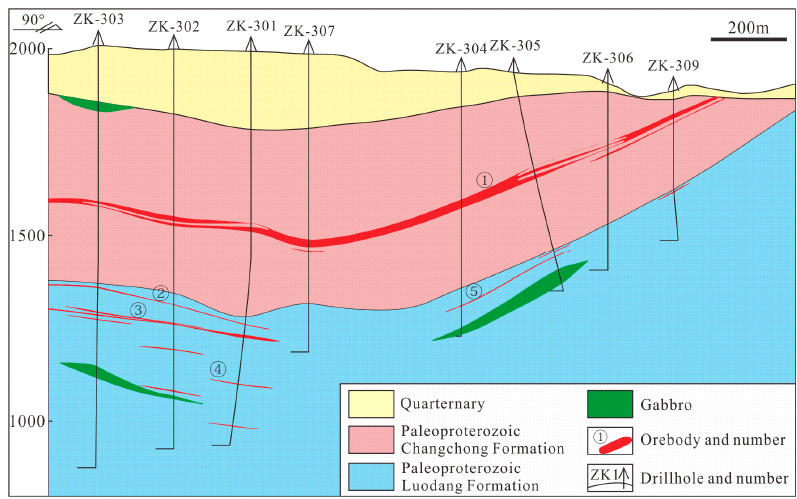
Figure 3. Geological cross-section of the number –3 exploration line of the Hongnipo copper deposit, showing the geometry of the orebodies and their relationships to the host rocks (modified after [26]).